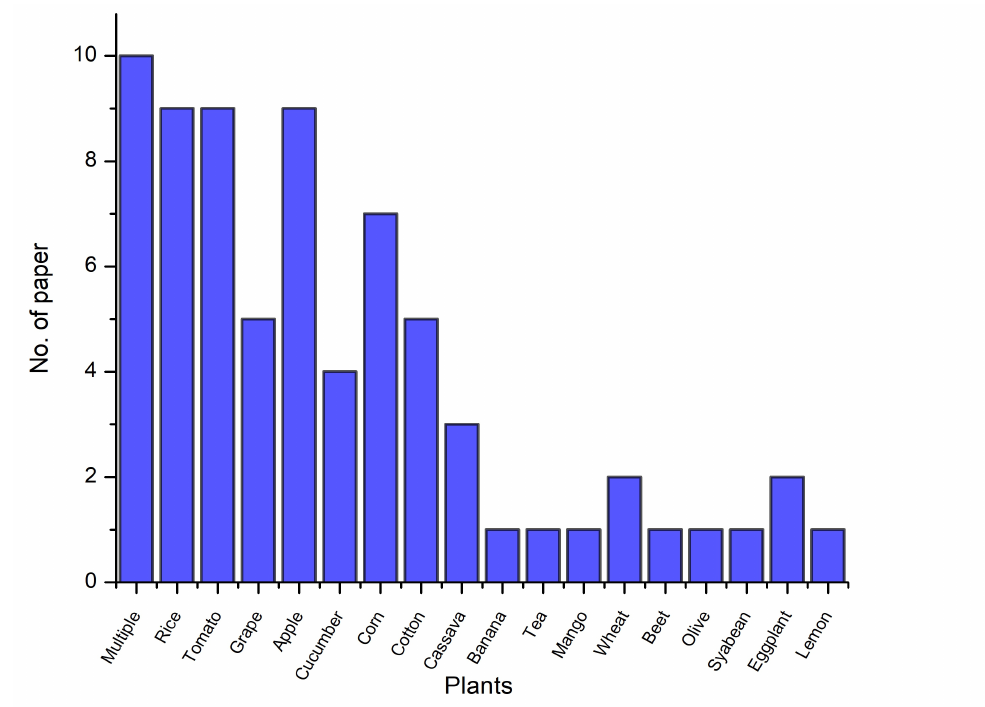
Figure 4. Number of research papers for different plant categories.